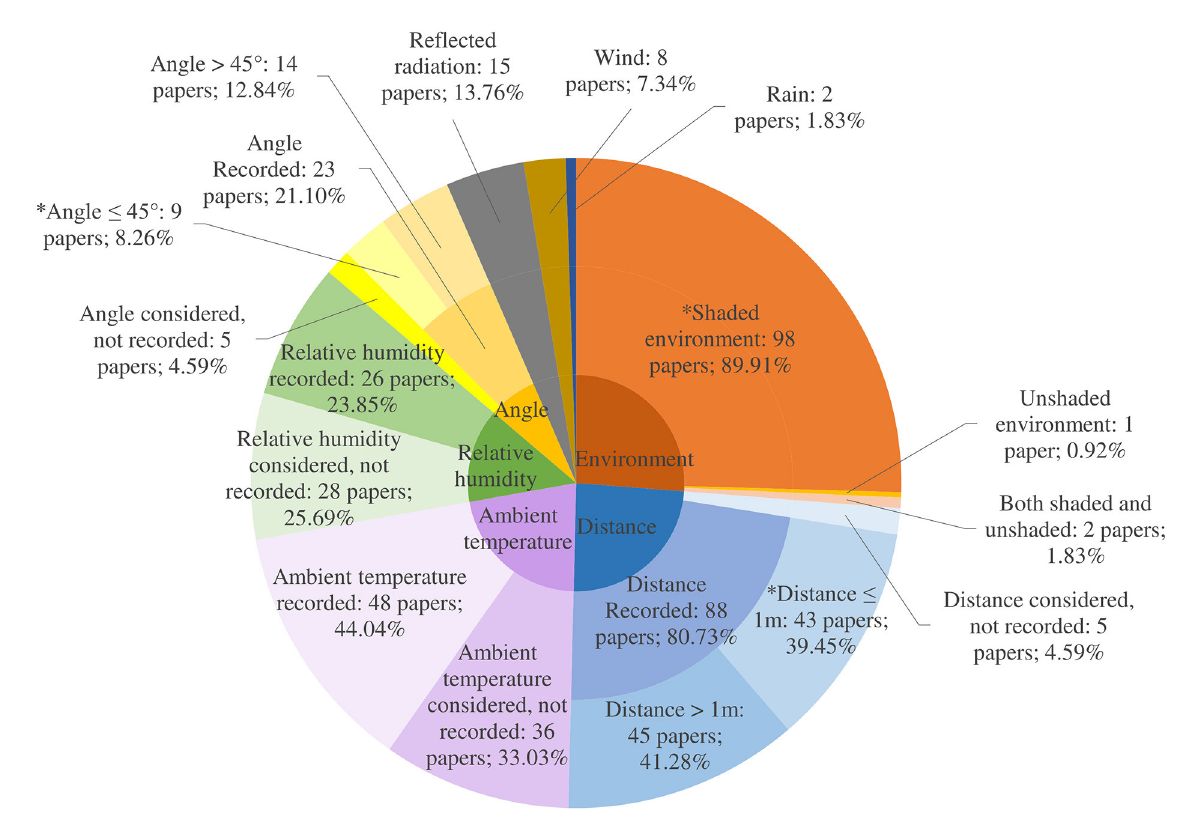
FIGURE8 Environmental parameter reporting where * denotes the recommended